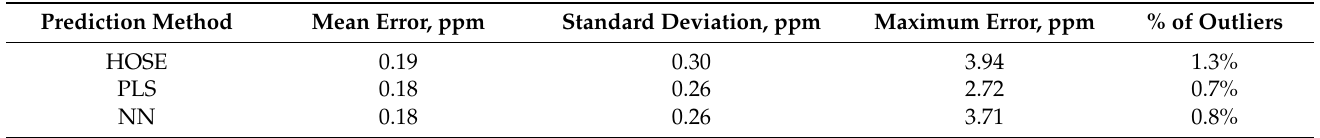
Table 4. The results for the prediction of 1 H chemical shifts by HOSE codes, PLS and NN algorithms. Outliers are defined as those shifts predicted with an error of more than 1.0